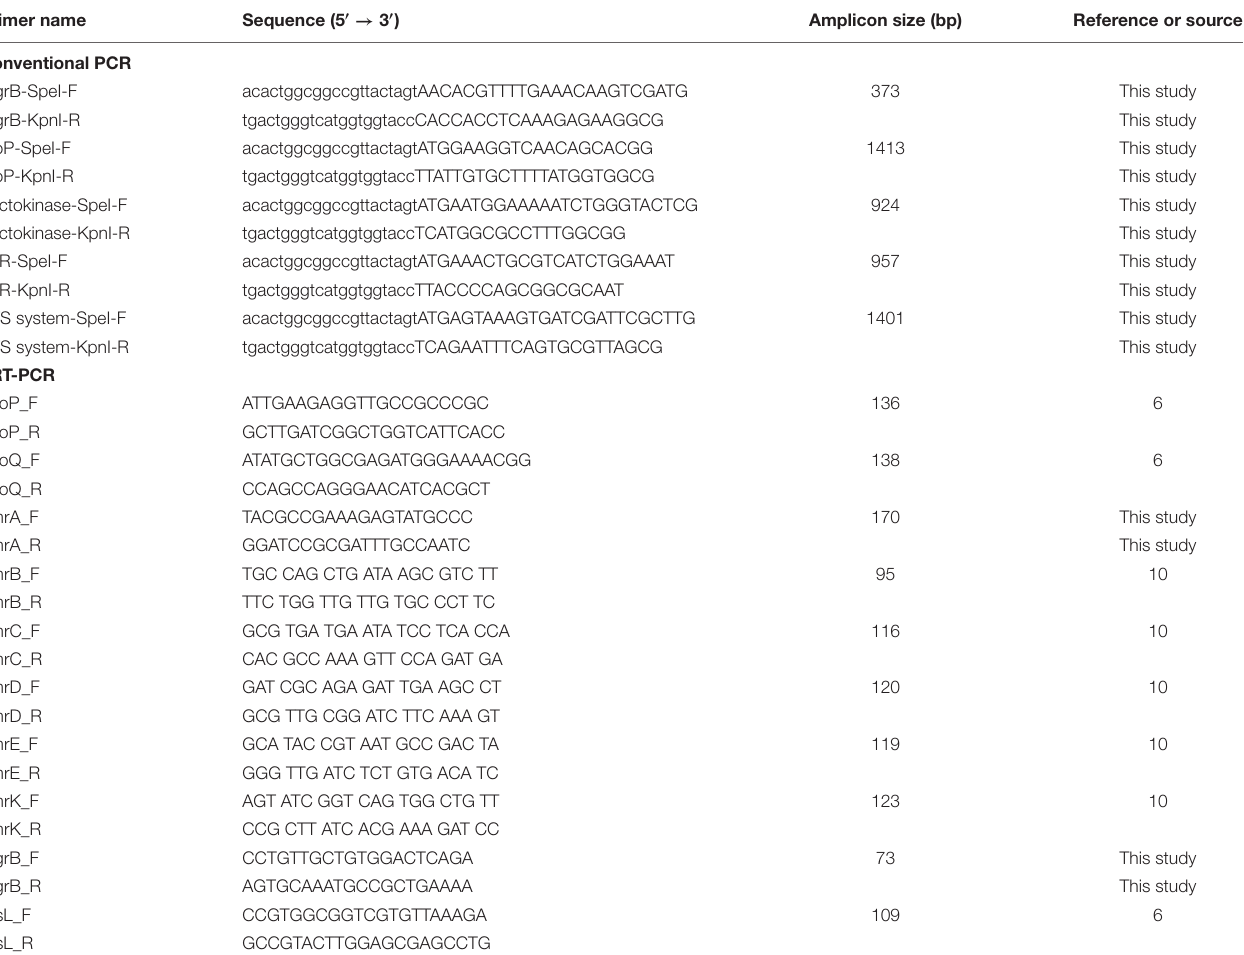
TABLE 1 | Primers used in this